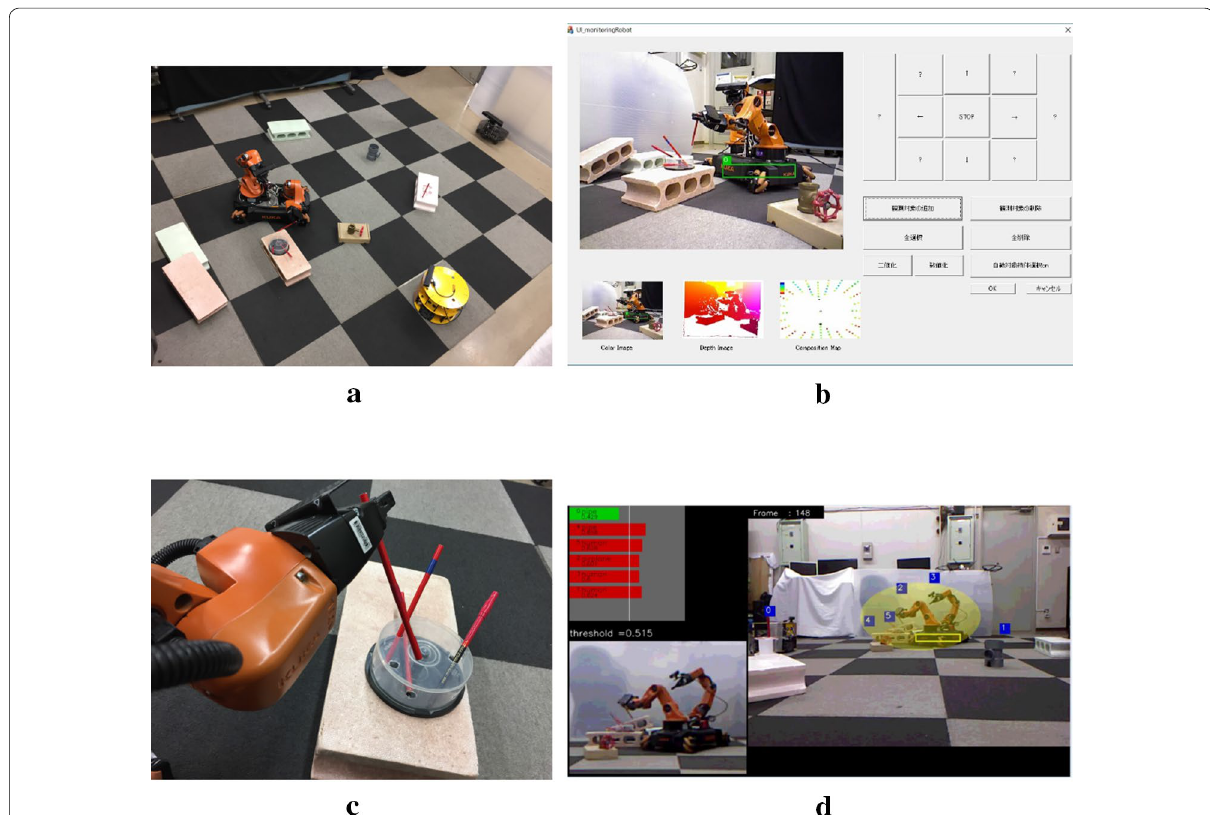
Fig. 16 Snapshot of experiment with support. a Working robot under operation, b control panel of local‑view monitoring robot, c view from work‑ ing robot, d view from wide‑view monitoring